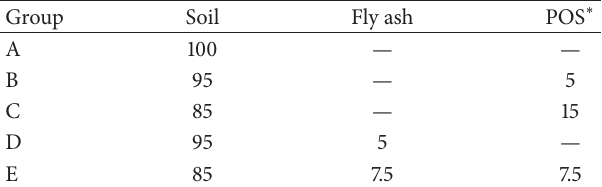
Table 2: Weight percentage of ingredients used in soil specimens.